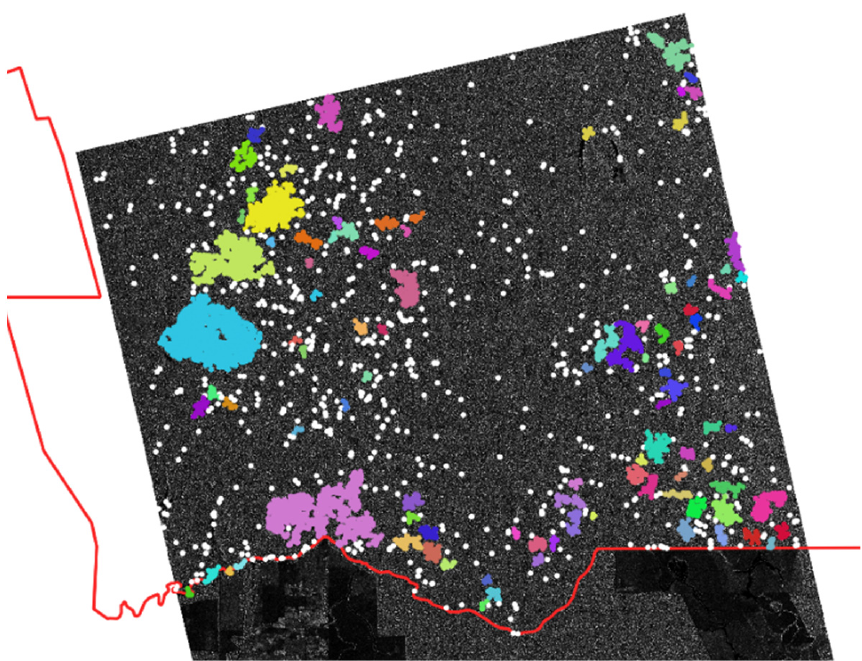
Figure 8. Polygons classified as logging (grouped—each color represents a group). In red, the Jamari NF limit.